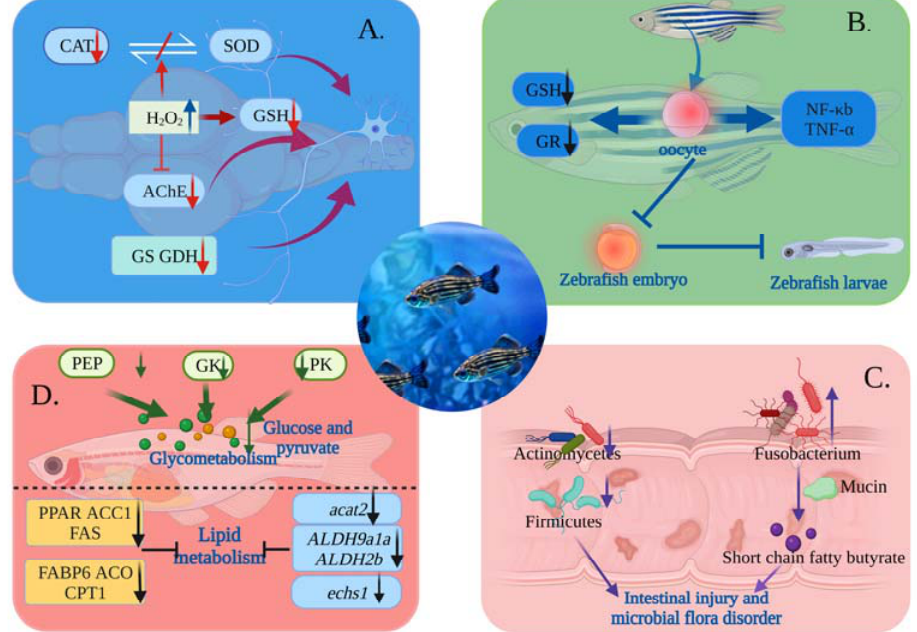
Figure 4. Diagram of the toxicological mechanism of MNPs in water explored using zebrafish. ( A ) The mechanism of central nervous toxicity of MNPs: Excessive production of H 2 O 2 , inactivation of enzyme protein, disruption of the balance between CAT and SOD activities, inhibition of AChE activity, and significant reduction in the activity of GS and GDH, leading to brain neurodegeneration. ( B ) Mechanism of reproductive toxicity of MNPs: MNPs were transferred to oocytes of adult female zebrafish, causing reduction of GR and GSH contents, leading to oxidative stress in oocytes. At the same time, NF-b and TNF- expression was significantly upregulated, affecting the offspring’s growth and development. ( C ) Effect of MNPs on zebrafish gut: Increased abundance of Fusobacterium metabolized mucin into short-chain fatty butyrate and induce intestinal inflammation in zebrafish. The number of actinobacteria decreased, foreign bodies accumulated in the intestine, and the number of Firmicutes decreased, all of which resulted in reduced mucus production and dam- age to the intestinal barrier. ( D ) The mechanism of metabolic toxicity of MNPs: Reduction of PEP, GK, and PK in the glycolytic pathway led to insu ffi cient glucose and pyruvate production, leading to disorders of glucose metabolism. Additionally, the expression levels of PPAR , ACC1 , FAS , FABP6 , ACO , CPT1 , acat2 , ALDH9a1a , ALDH2b , and echs1 genes were reduced, resulting in abnormal lipid